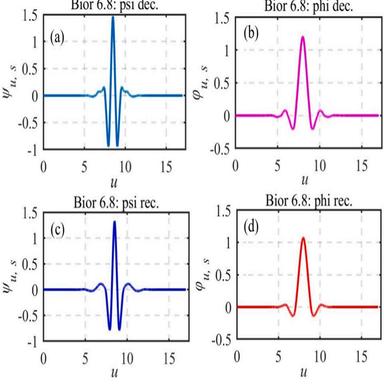
Bior 6.8 wavelet: (a) the wavelet function and (b) the scaling function for decomposition, (c) the wavelet function and (d) the scaling function for reconstruction.